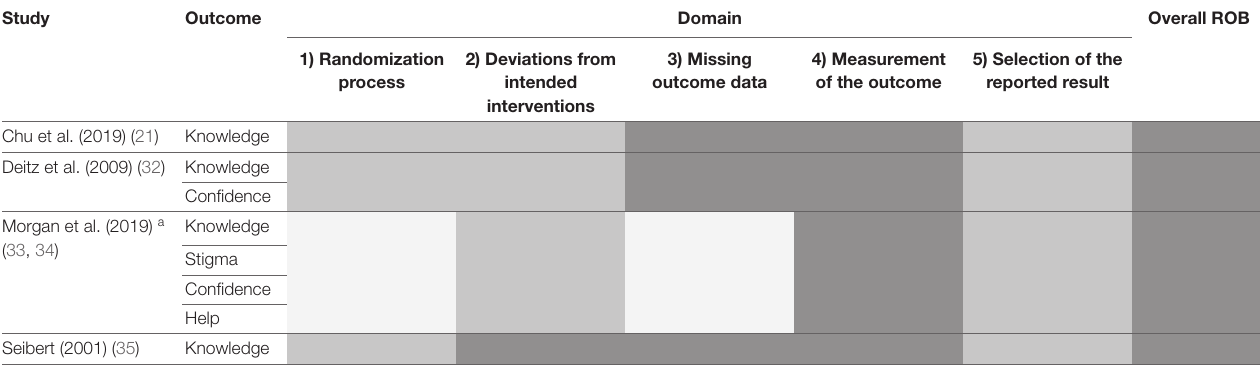
TABLE 2 | ROB in the five domains and overall ROB for 4 outcomes in randomized controlled trials. Study Outcome Domain